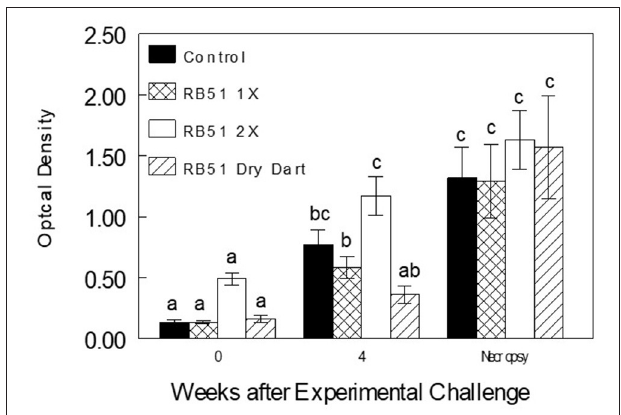
FIGURE 4 | Serologic responses of bison to γ -irradiated B. abortus strain 2308 (2308) in an ELISA assay after experimental challenge in mid-gestation with 10 7 CFU of 2308. Bison treatments included non-vaccinated (Control), or vaccination with 10 10 CFU of B. abortus strain RB51 (RB51) in a single parenteral inoculation (RB51 1X), a boostered parenteral inoculation (RB51 2X), or in a novel dry dart formulation (RB51 Dry Dart). Responses are presented as mean titer ± SEM. Means with different superscripts are significantly different ( P <